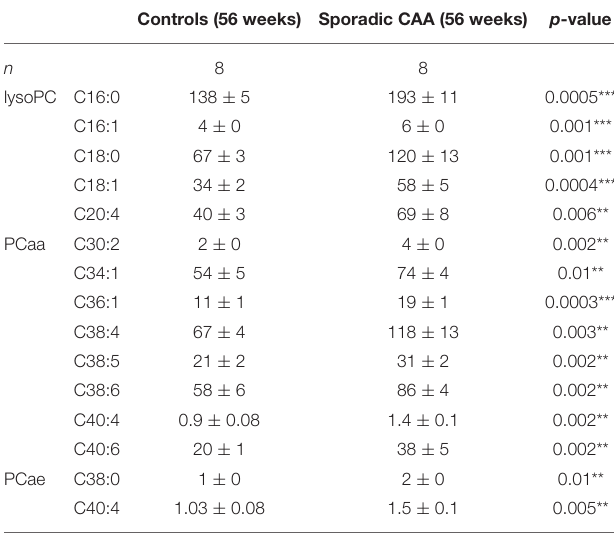
TABLE 2 | Platelet levels of selected lipids altered in CAA mice. Controls (56 weeks) Sporadic CAA (56